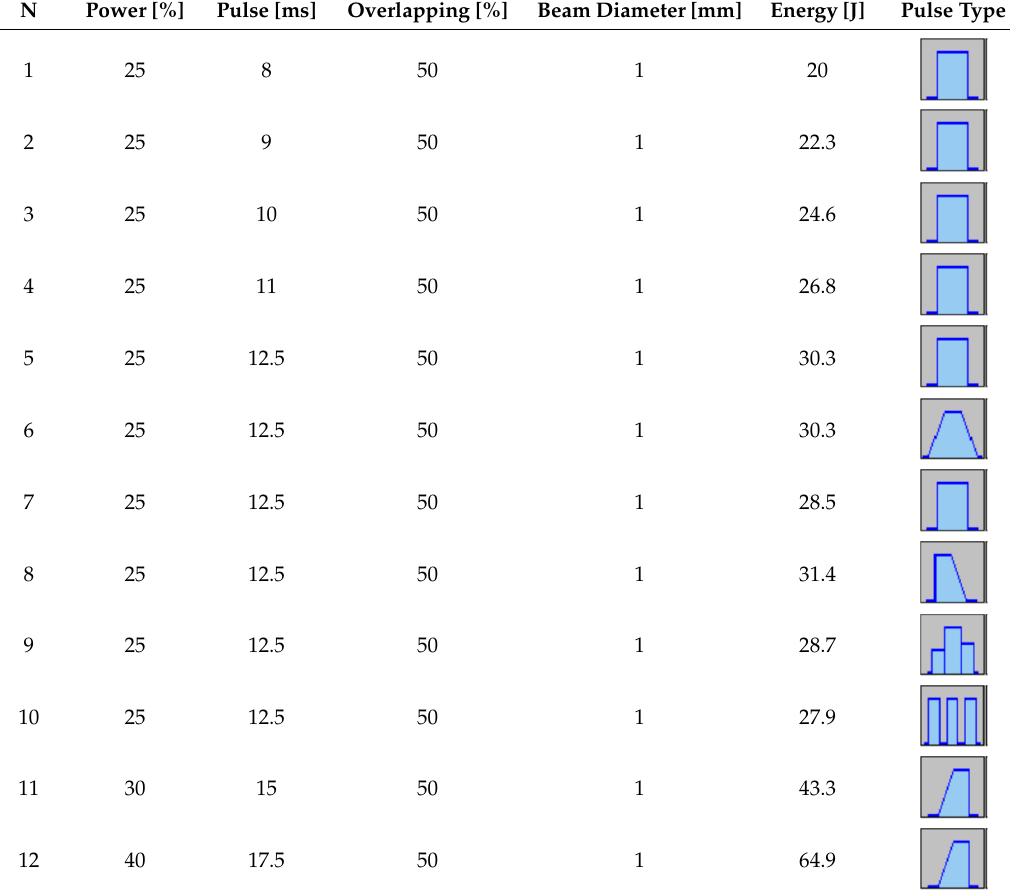
Table 4. Welding parameters.